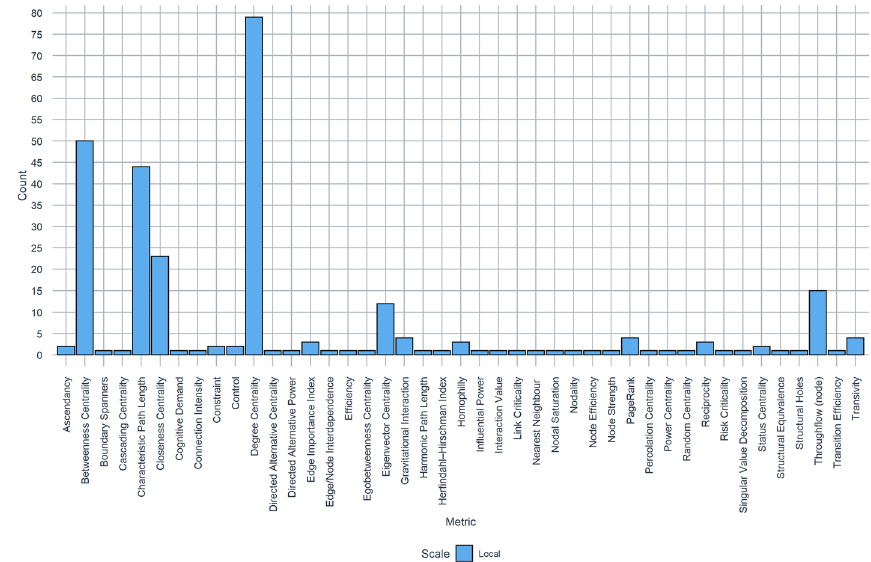
Fig. 5 Frequency of local network metrics